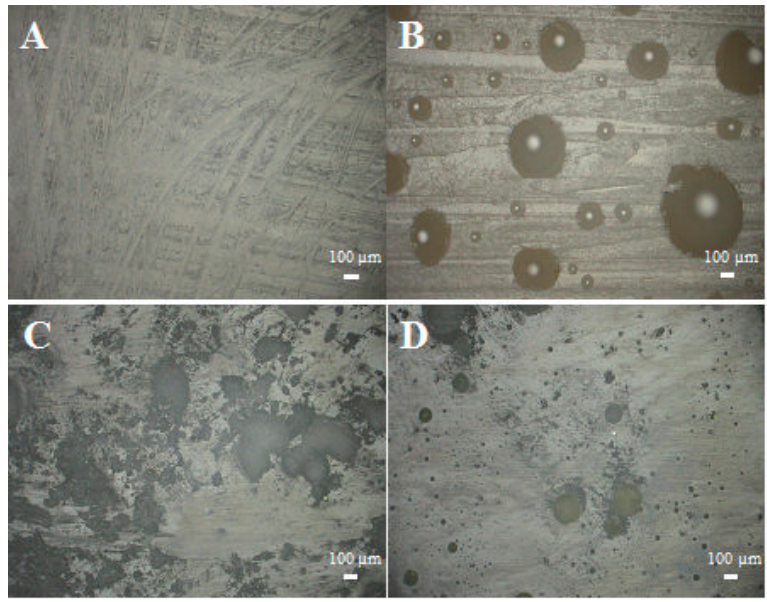
Figure 6. Photos of the samples’ surfaces, upper part, ( A )—glass, degassed; ( B )—glass, non-degassed; ( C )—silicone, degassed; ( D )—silicone, non-degassed.